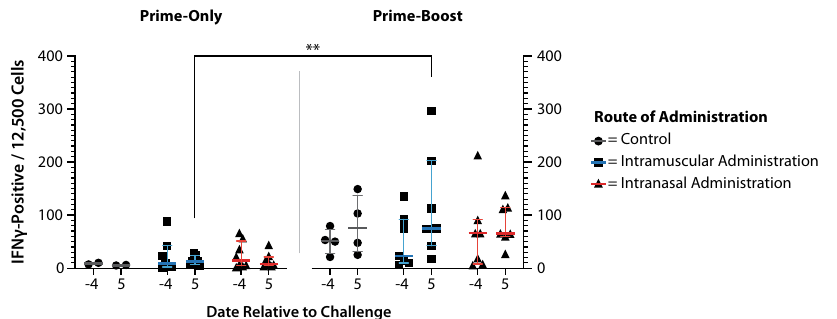
Fig. 4 IFN γ -producing PBMC levels pre- and post challenge. PBMCs were isolated from blood samples taken on days − 4 and 5, relative to challenge, for quanti fi cation of circulating IFN γ -producing cells by ELISpot assay. Prime-only animals had few IFN γ -producing cells, whilst prime-boost animals had greater numbers. Comparison of intramuscular prime-boost with prime-only post-challenge results demonstrated statistical signi fi cance (** P < 0.01). Horizontal lines represent mean and in any ferret samples collected on day 11 or 14 post challenge 52 for prime-boost animals) had detectable levels of SARS-CoV-2 E (study days 39 and 42 for prime-only animals; study days 67 and RNA, as determined by RT-qPCR. 70 for prime-boost animals; data not shown). Viral RNA loads (log 10 SARS-CoV-2 E copies/mL) for each sample Compared to the control animals, average levels of virus collected post challenge are presented in Fig. 5 for days 3, 5, 7 and shedding (as determined by RT-qPCR) in nasal-wash and oral swab 9 post challenge. These time points correspond to study days 31, samples were lower for each ChAdOx1 nCoV-19 Study Group. 33, 35 and 37 for prime-only animals, and study days 59, 61, 63 These reductions were statistically signi fi cant ( P < 0.05) in nasal- and 65 for prime-boost animals. No virus shedding was detected